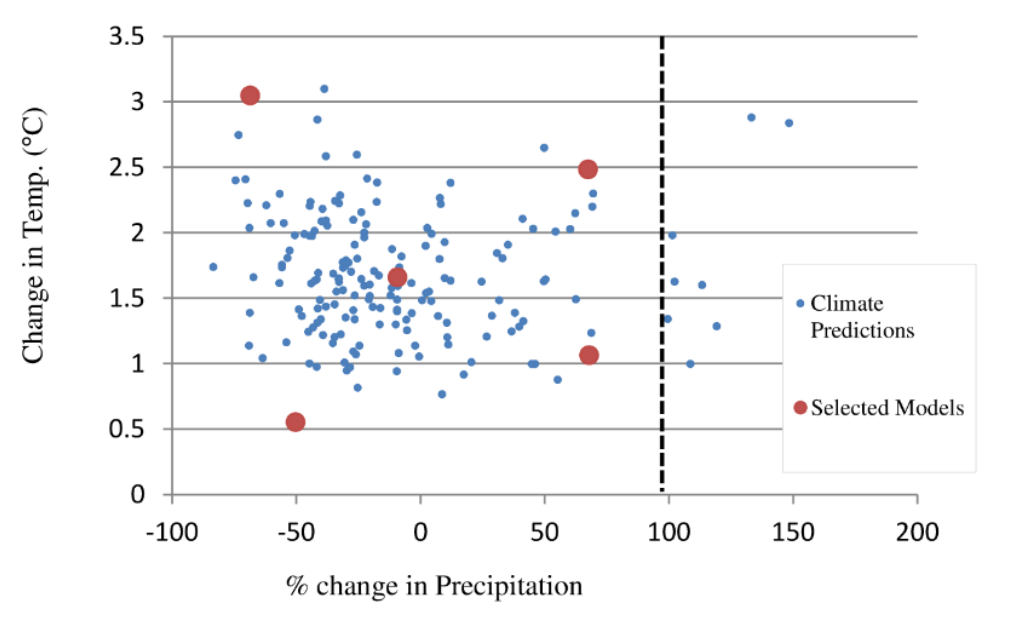
Figure 2. Shown is ∆(cid:1846) (cid:1874)(cid:1871). ∆(cid:1842) , 30-year average percent change in climate (Copiapó, Chile example). Blue points indicate all climate models with emission scenarios while red points are the chosen representative scenarios. Vertical dotted line indicates cut-off for outliers (>2.5 standard deviations above